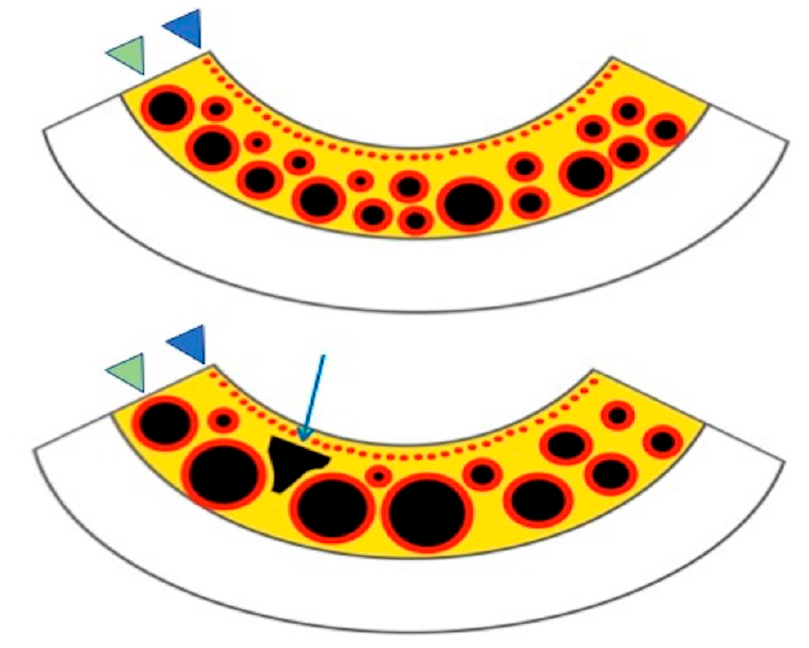
Figure 4. Drawing showing the possible pattern of choroidal rift formation in eyes with central serous chorioretinopathy. A schematic representation of a normal (top) and thickened choroid in CSC (bottom) showing the choriocapillaris (small red circles highlighted with the blue head arrows) and Sattler’s and Haller’s layers (red and black circles highlighted with the green head arrows) within choroidal stroma (yellow regions). An expansion of the choroid occurring in CSC is accompanied by a reduction in both choriocapillaris and larger large-sized choroidal vessels. The latter event, along with an antero-posterior stretching of the choroidal volume, may cause a mechanical stress to the choroidal stroma resulting in the development of a choroidal rift (highlighted with the blue arrow).